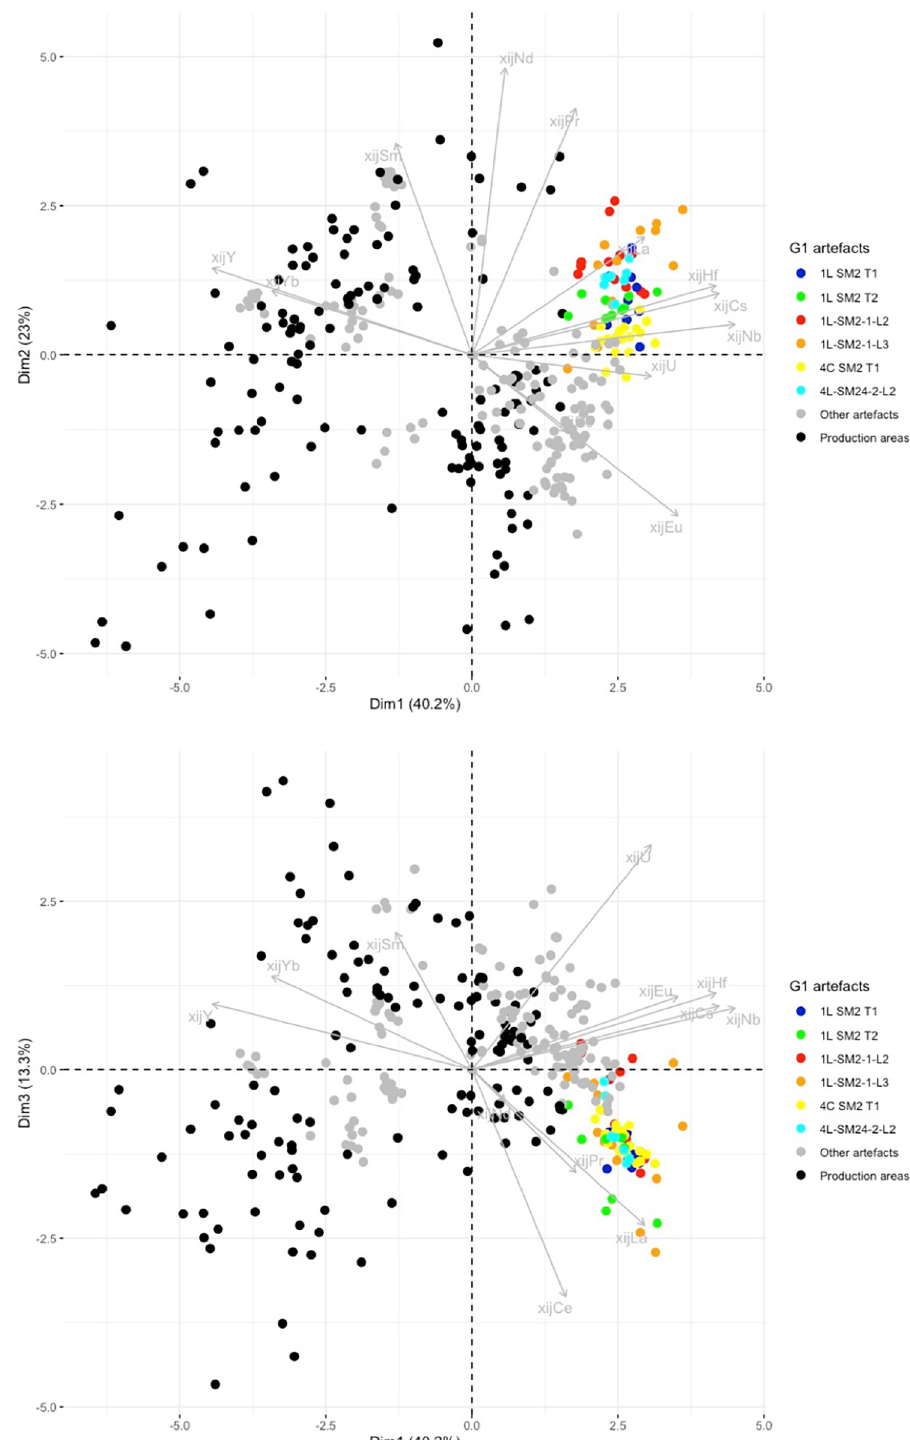
Fig 14. PCA on xij of production area slag. Artefacts of Group G1 are coloured (each colour corresponds to an artefact. Production areas are presented in black. % between brackets: % of total variance.